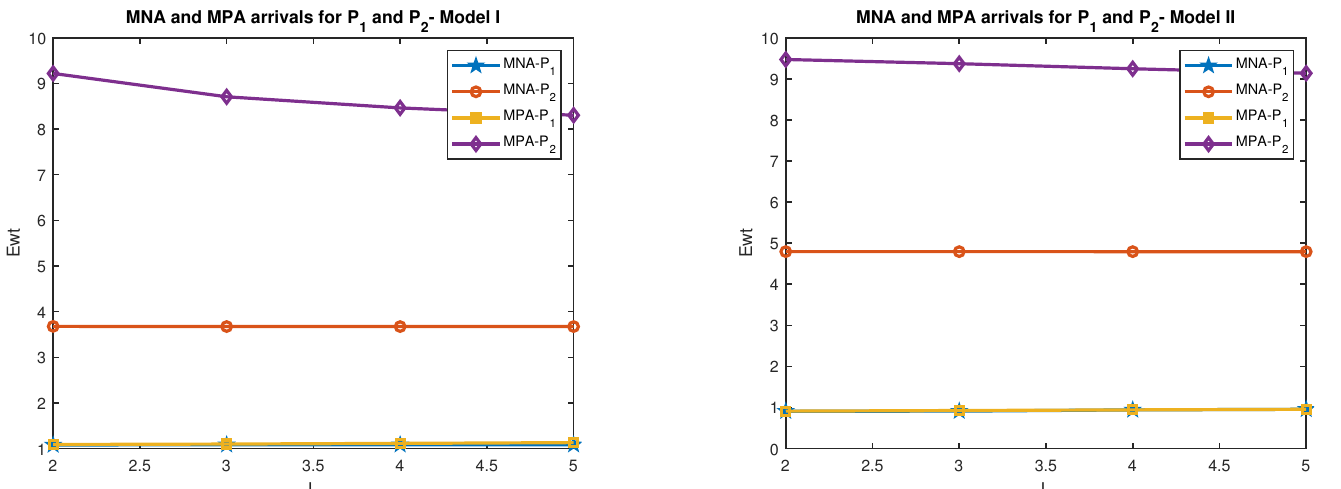
Figure 3. Effect of L on expected waiting time of P 1 and P 2 customers in the system for MNA and MPA arrival processes with correlation of − 0.4211 and 0.4211, respectively (when θ = 0.6).